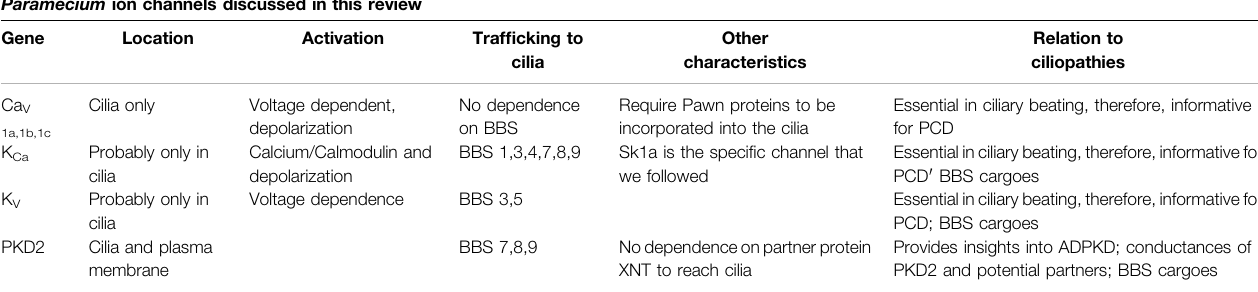
TABLE 1 | Summary of the ciliary ion channels in this review organized by their membrane location, how they are activated, how they are traf fi cked to the cilia, and other pertinent characteristics including how they relate to ciliopathies. Paramecium ion channels discussed in this